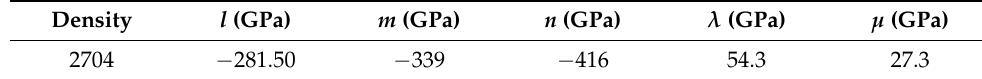
Table 1. Material properties used in the finite element